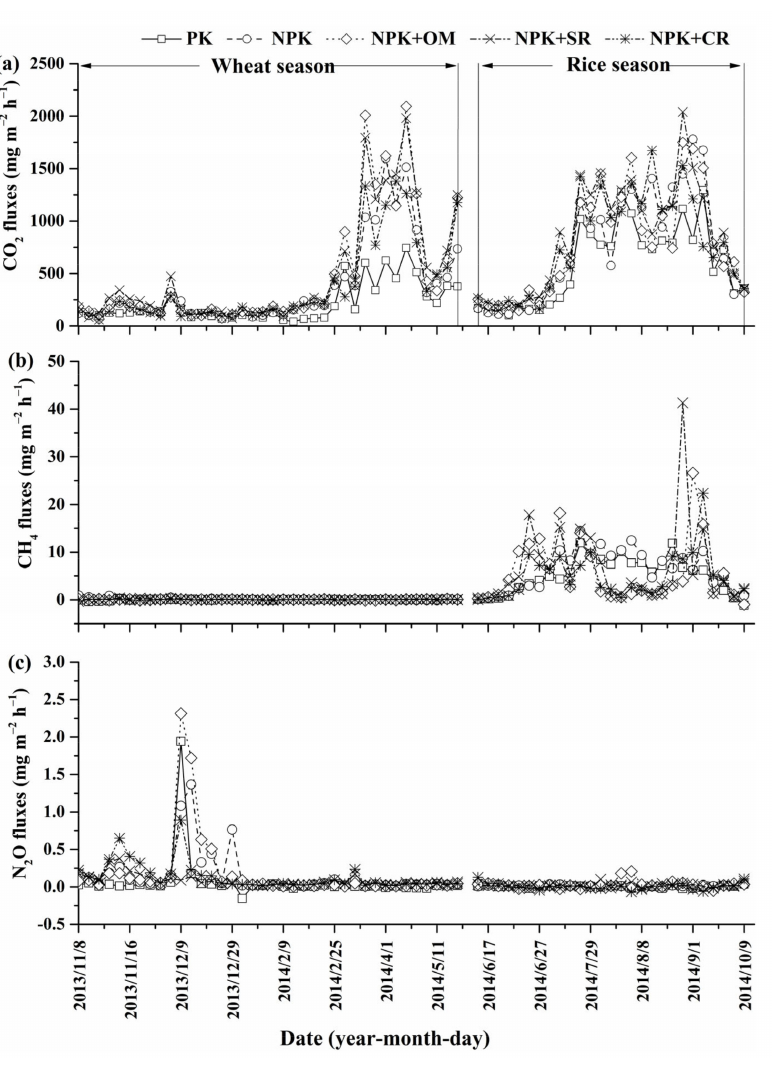
Figure 3. Seasonal variations of ( a ) ecosystem respiration CO 2 , ( b ) CH 4 , ( c ) N 2 O during the rice-wheat rotation from 2013 to 2014.